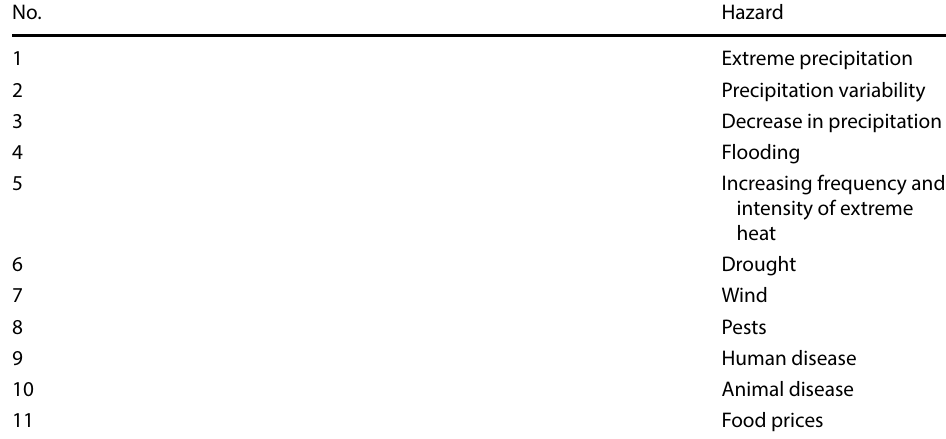
Table 2 List of hazards identified during the interviews with